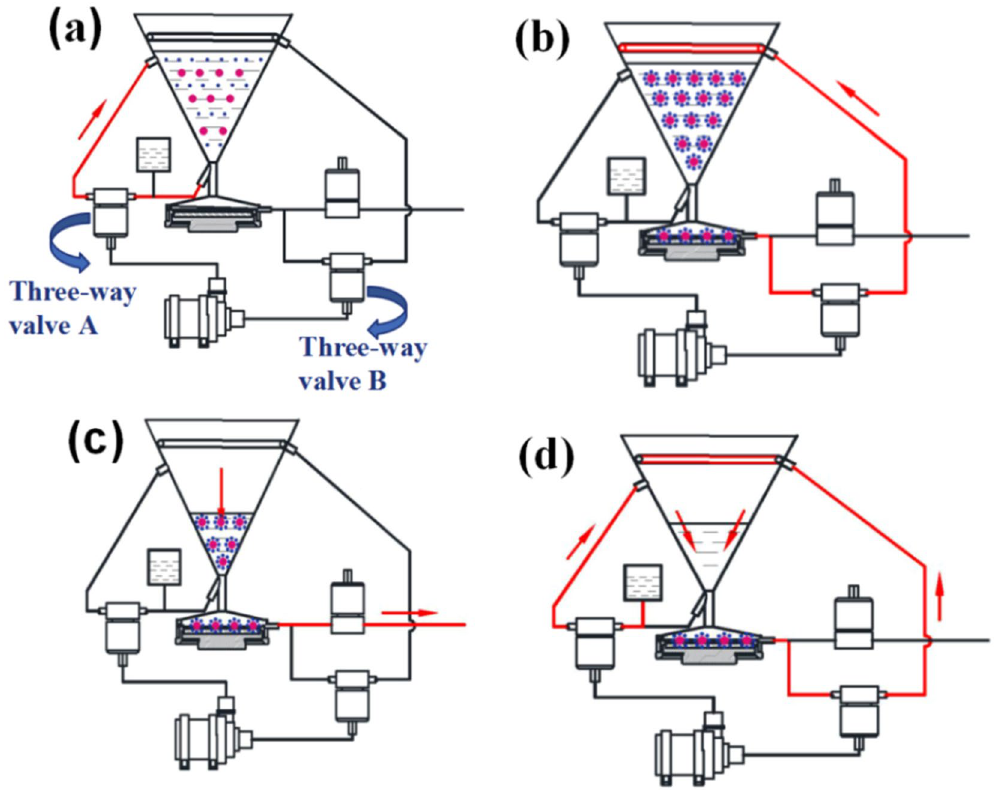
Figure 2. Procedure for magnetic solid phase extraction (MSPE). ( a ) circulated contact of M88 and PPCPs solution; ( b ) transfer of mixed solution of M88 and PPCPs into solid–liquid separation zone; ( c ) electromagnetic separation of M88 microsphere from mixed solution; ( d ) the transfer and collection of residual M88 by circulation